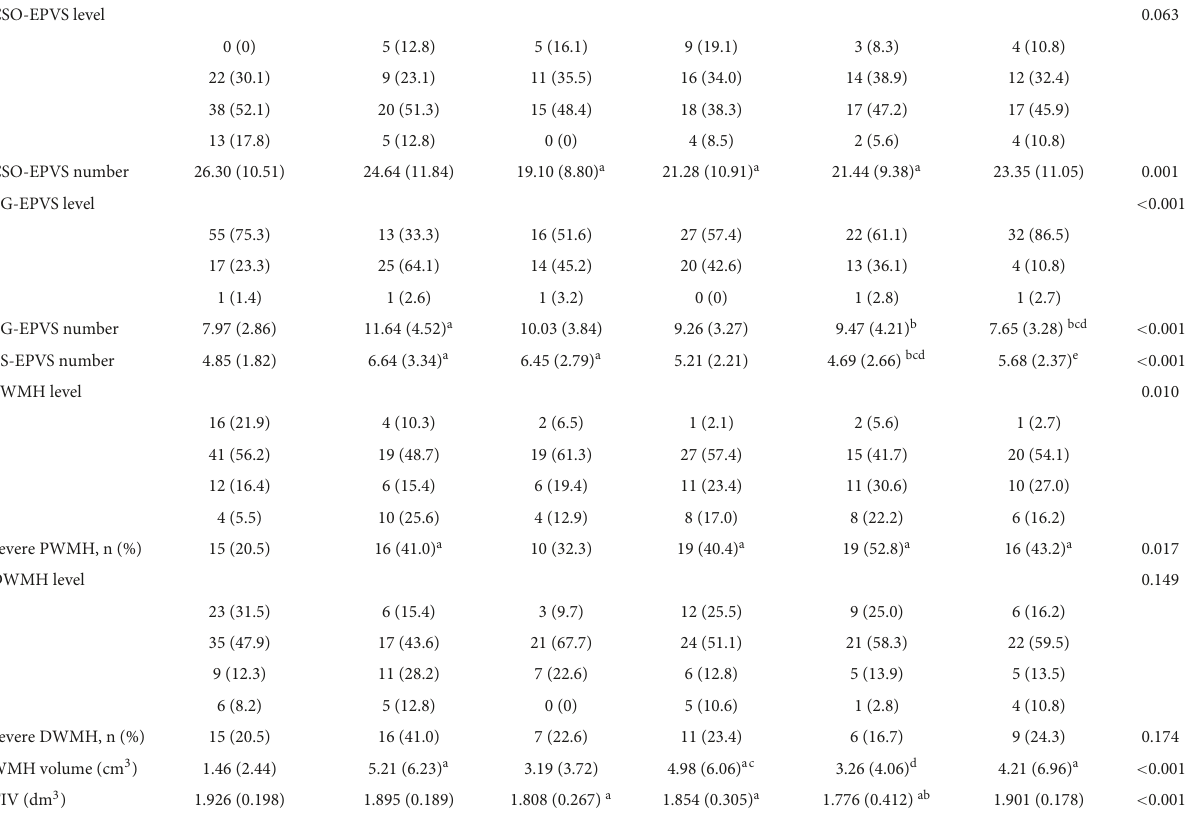
TABLE 2 Prevalence of EPVS and WMH across all